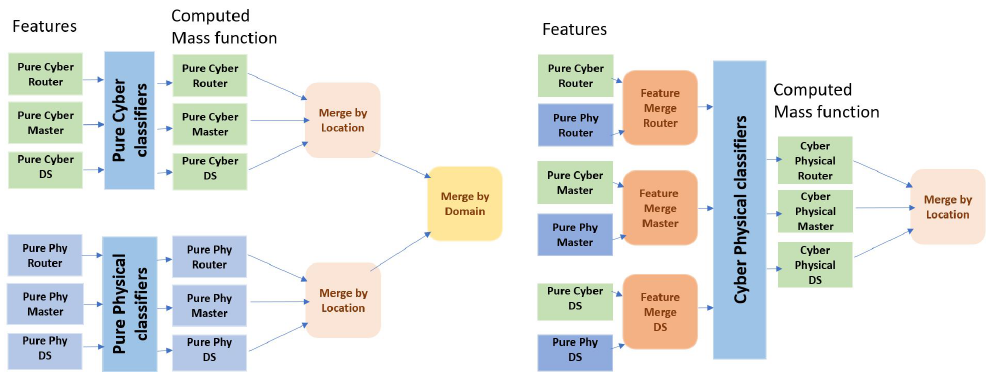
Figure 3. ( Left ) Fusion by location and domain (FLD) from pure cyber and physical classifiers. ( Right ) Fusion by location (FL) from cyber-physical